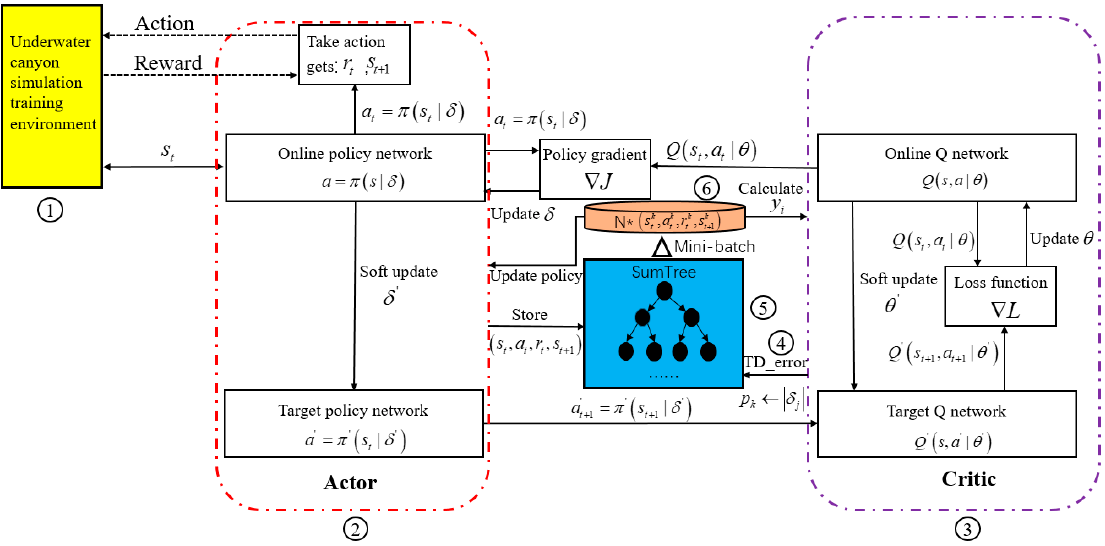
Figure 6. SumTree-deep deterministic policy gradient (SumTree-DDPG) algorithm structure diagram. (1): Under canyon simulation training environment is established by the information detected by the sonars of AUV. (2): Actor is a double-layer fully connected neural network structure composed of online policy network and Target policy network, which is used to obtain the optimal action output by interacting directly with under canyon simulation training environment. (3): Critic is a double-layer neural network structure composed of online Q network and target Q network, which is used to evaluate the action of Actor’s selection. (4): Temporal-difference calculated by Critic. (5): Experience replay memory with SumTree-structure. (6): n samples with proportional prioritization.